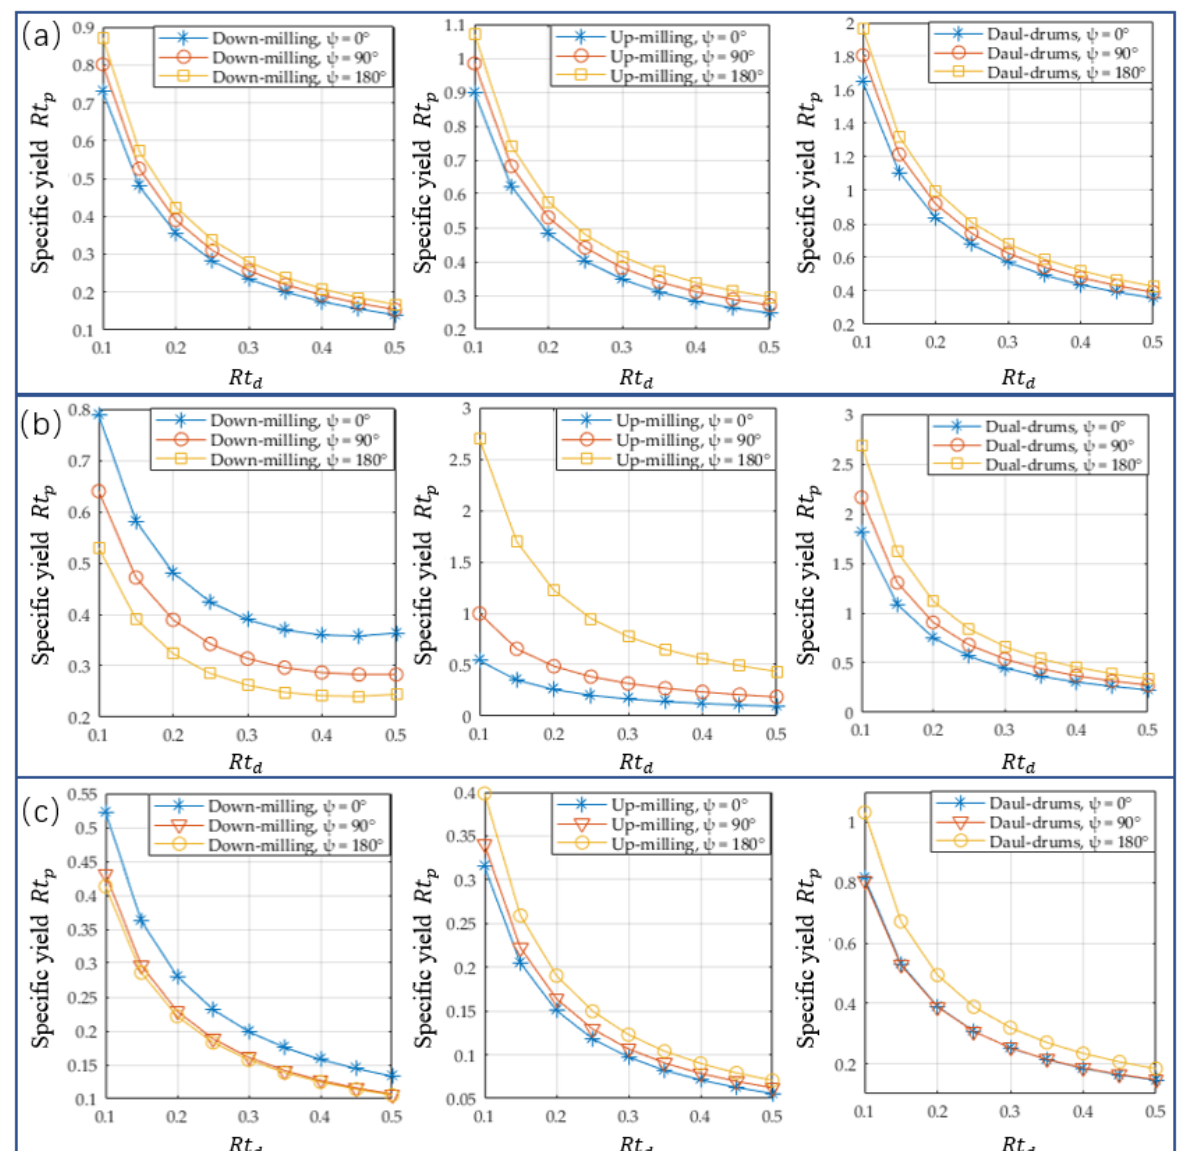
Figure 11. Influence of sump depth on the stability. ( a ) Slope stability condition; ( b ) anti-slip stability condition; ( c ) anti-skid steering stability condition.